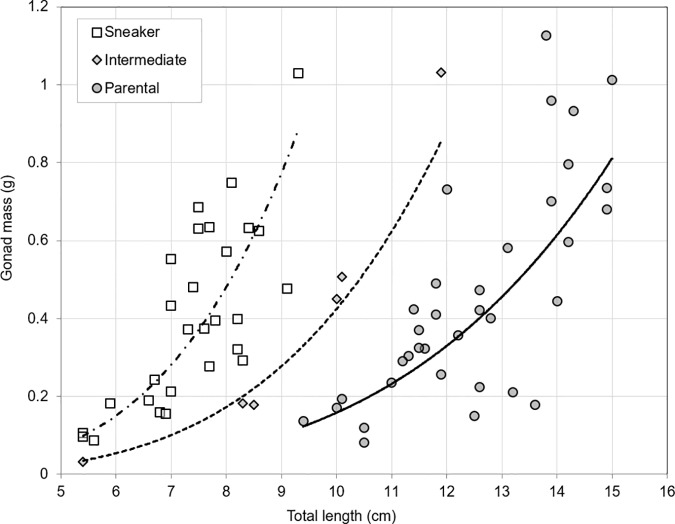
Gonad mass plotted against total length for Round Goby sneaker morphs (n = 28), intermediates (n = 6) and parental morphs (n = 35).Lines indicate fitted power curves.